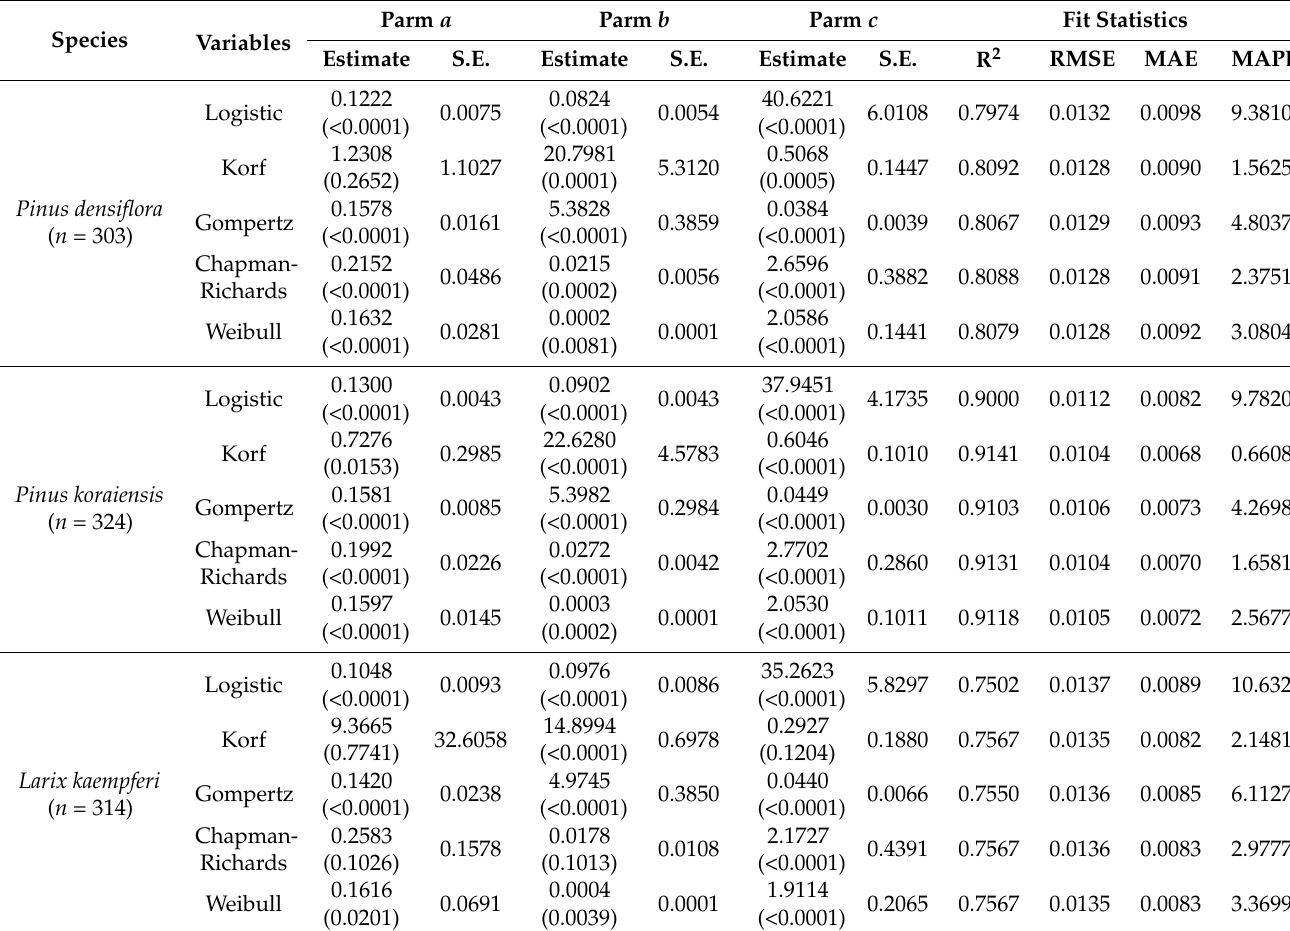
Table 5. Model parameters of basal area growth functions and indicators of